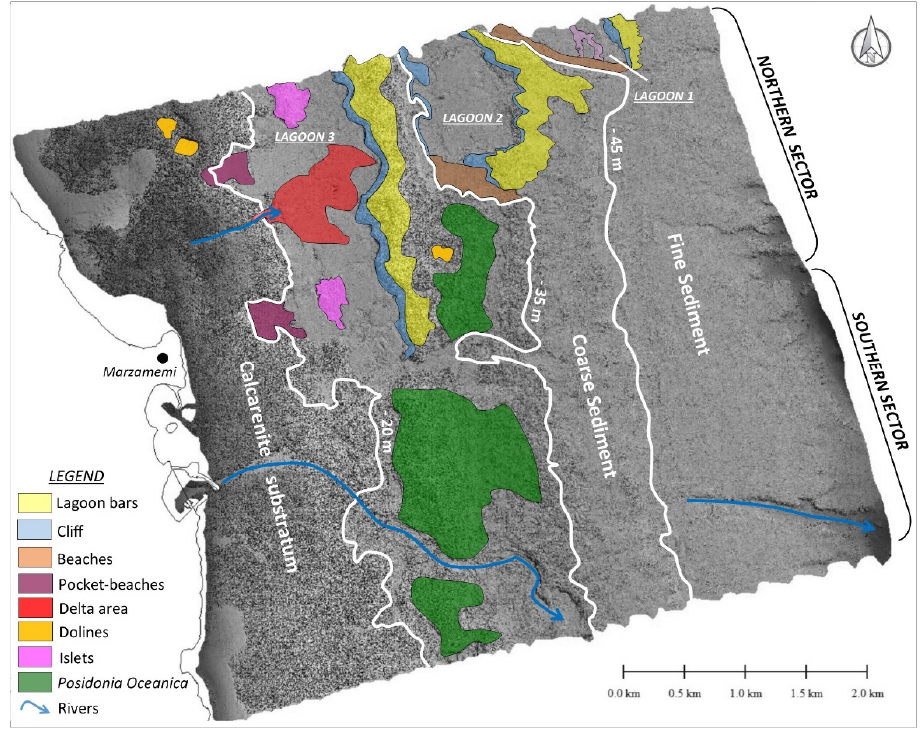
Figure 16. Mapping of the geomorphic elements identified in the proximal offshore area of the Marzamemi village (Syracuse, Sicily) and connected to the Holocene sea-level variations.